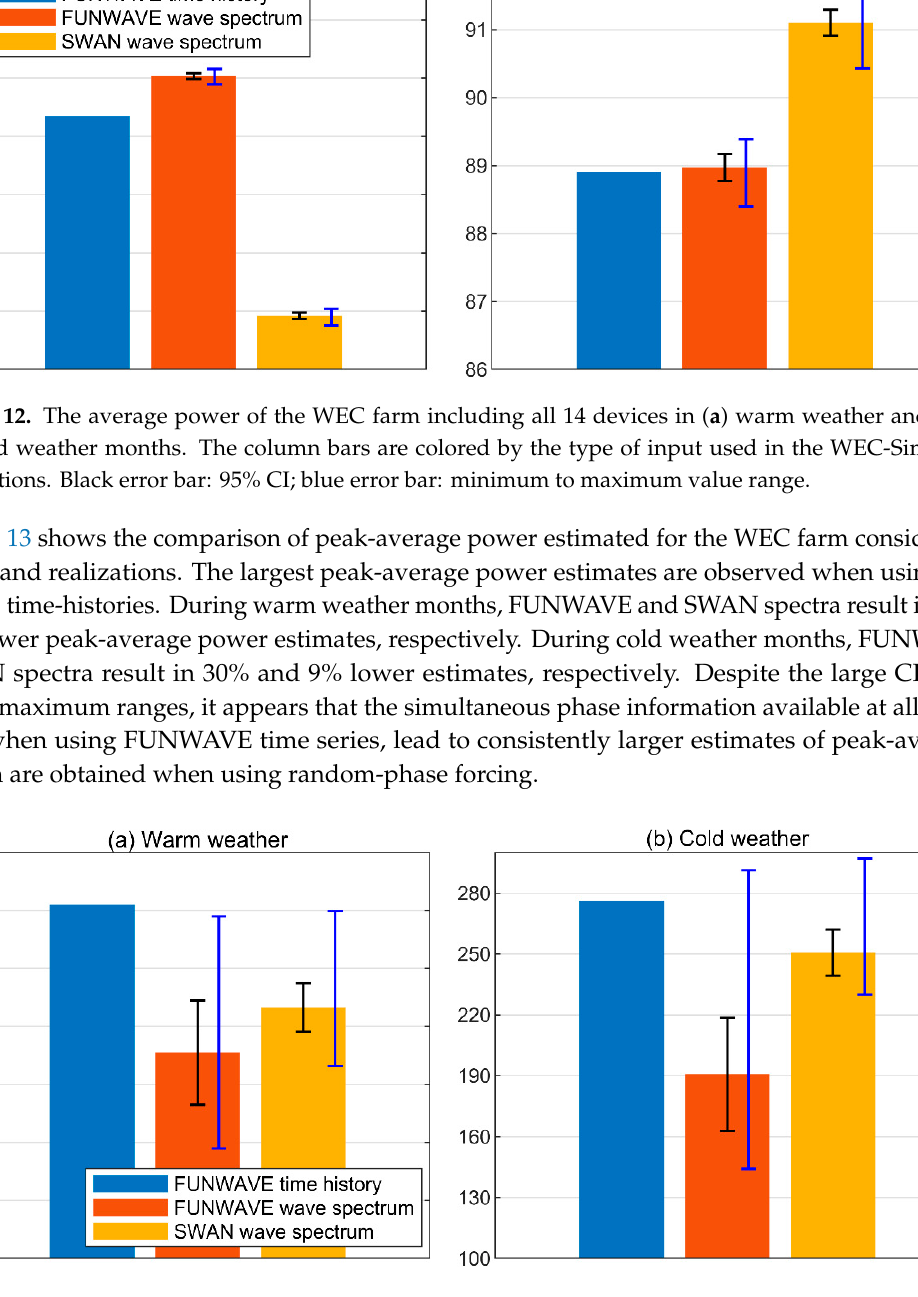
Figure 11. Average power of individual devices in the WEC farm under ( a ) warm and ( b ) cold weather conditions. The column bars are colored by the type of input used in the WEC-Sim simulations. The red error bars indicate the 95% CIs.